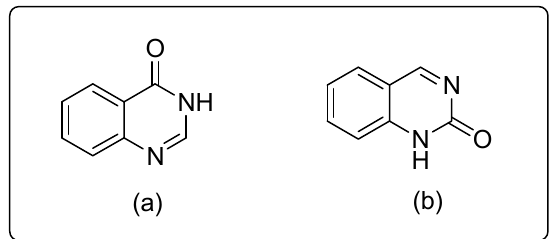
Figure 1. 2-quinazolinone ( a ) and 4-quinazolinone ( b ).